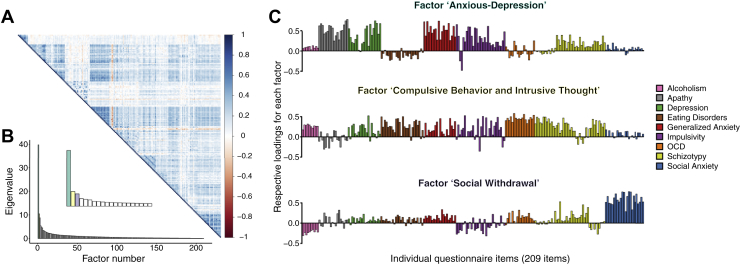
Three latent factors (dimensions) explained the shared variance between all questionnaire items. (A) Correlation matrix of 209 questionnaire items showing significant correlations between the answers to questionnaire items across subjects. The color scale indicates the correlation coefficient. (B) Eigenvalues from the factor analysis revealing a three-factor solution that best accounted for our data. We labeled these factors anxious-depression, compulsive behavior and intrusive thought, and social withdrawal, according to the strongest individual item loadings. The inset corresponds to a zoom on the first few factors. (C) Item loadings onto each factor, color-coded by questionnaire. See also Supplemental Figures S1 and S2. OCD, obsessive-compulsive disorder.